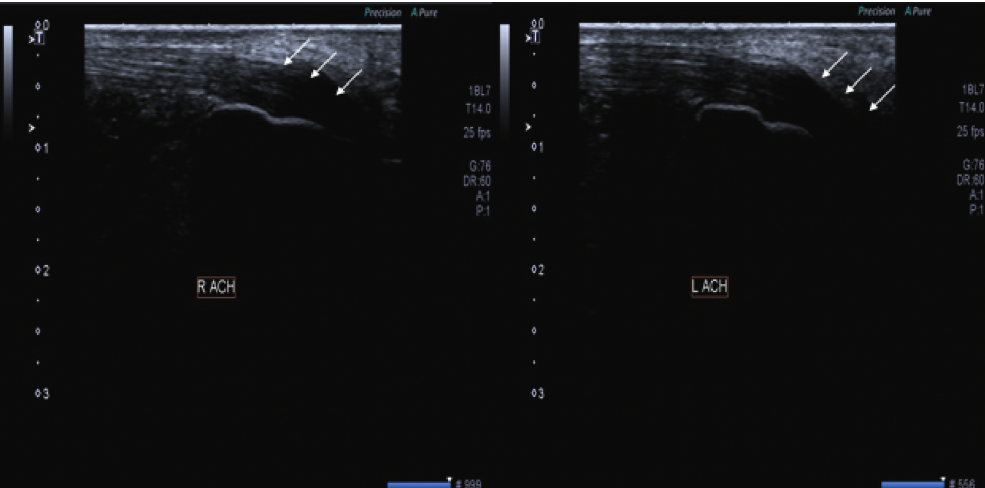
Figure 5: Extensor tendons of bilateral Achilles show thickening and hypoechogenicity representing tendonitis (white arrows).